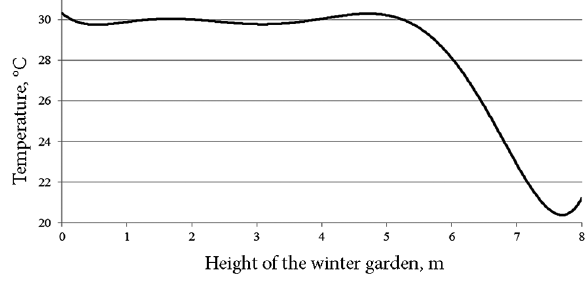
Figure 8. Modification of temperature at the height